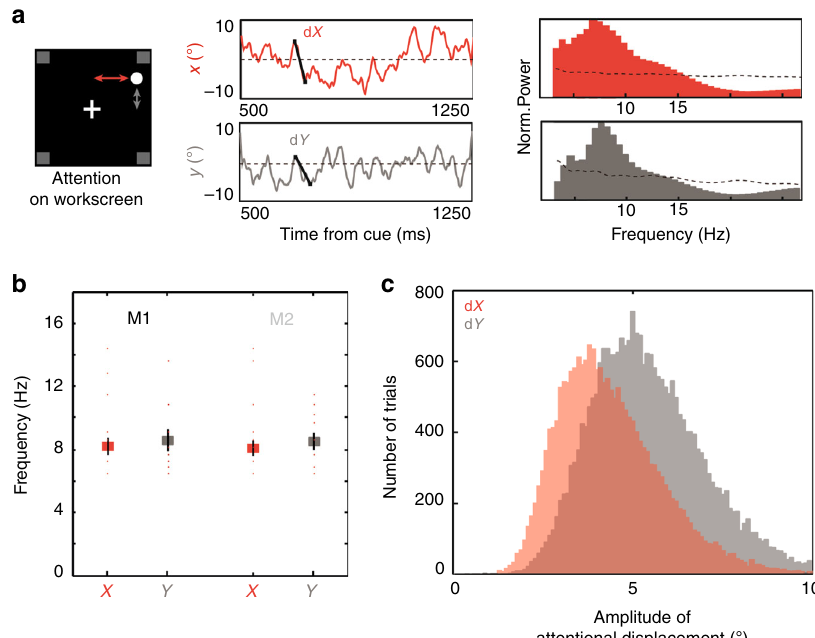
Fig. 8 The spatial oscillations in PFC attentional information map onto changes in attentional spotlight position in space. The ( x , y ) position of the attentional spotlight ( a , left panel: x , red; y , gray) varies in time ( a , middle panel) at a frequency ( a , right panel, dotted black line, 95% con fi dence interval) that matches the frequency characterized in overall PFC attentional information (cf. Fig. 2). b Mean maximal power peak frequency of attentional spotlight trajectory for M1 and M2, in x (red) and y (gray), individual data points plotted in red. c Distribution of amplitude of attentional displacement during the cue to target interval (500 – 1250 post cue), along the x (gray) and in y (red)